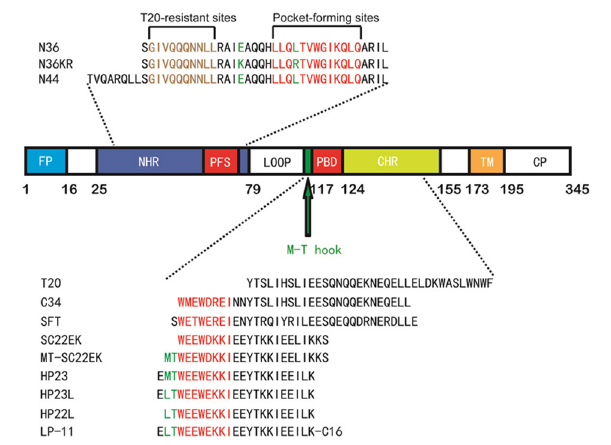
FIGURE 1 | Schematic illustration of HIV-1 gp41 and its peptide fusion inhibitors. The functional domains of gp41 and the sequences of NHR or CHR-derived peptides are presented. The gp41 numbering of HIV-1 HXB2 is used. FP, fusion peptide; NHR, N-terminal heptad repeat; PFS, pocket-forming sites; PBD, pocket-binding domain; CHR, C-terminal heptad repeat; TM, transmembrane domain. The sequences of NHR- and CHR-derived peptides are listed. The sequence corresponding to the T20-resistant site is marked in brown; the sequences corresponding to the NHR pocket region and the pocket-binding domain (PBD) are marked in red. The position and sequence of the M-T or L-T hook structure as well as the E49K and L57R mutations are shown in